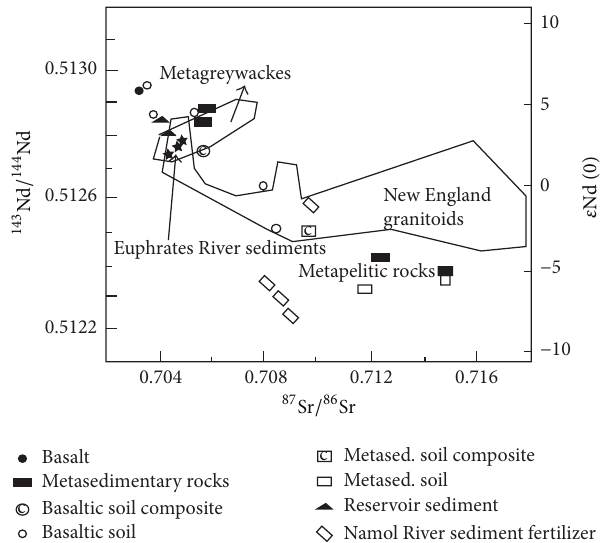
Figure 5: Diagram of Nd versus Sr isotopic composition in rock, soil, and sediment samples from Martin and McCulloch [4]. Lines connectrockandsoilsamplestakenfromthesamelocality.Outlined fields show isotopic compositions of the New England granitoids, metapelitic rocks, and metagraywackes from the New England fold belt [49].